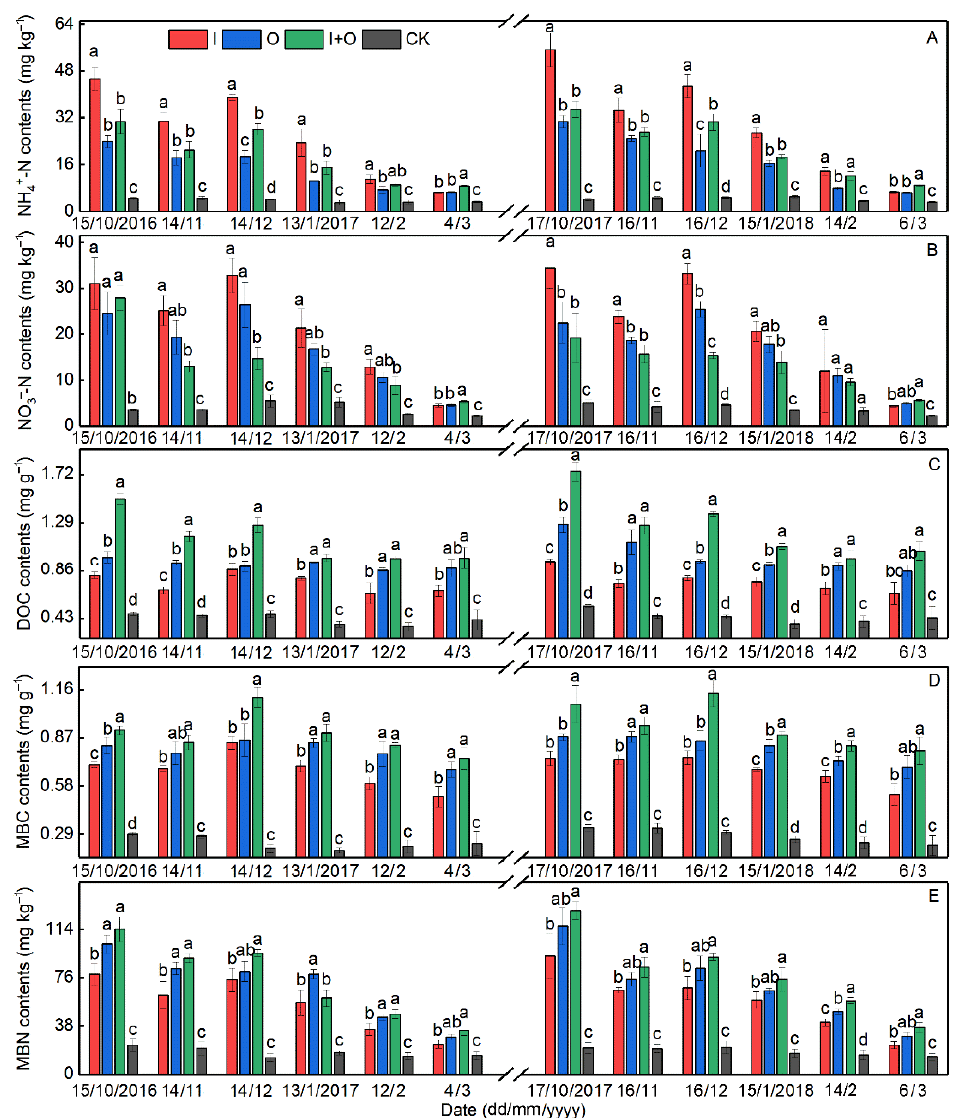
Figure 2. Soil chemical properties including NH 4+ –N ( A ), NO 3– –N ( B ), DOC ( C ), MBC ( D ) and MBN ( E ) contents under different treatments throughout two growing seasons of purple caitai. Different letters indicate significant differences at the level of 0.05. DOC, dissolved organic C; MBC, microbial biomass C; MBN, microbial biomass N; I, inorganic N fertilization; O, organic N fertilization; I+O, integrated organic/inorganic N fertilization; CK, no fertilization.